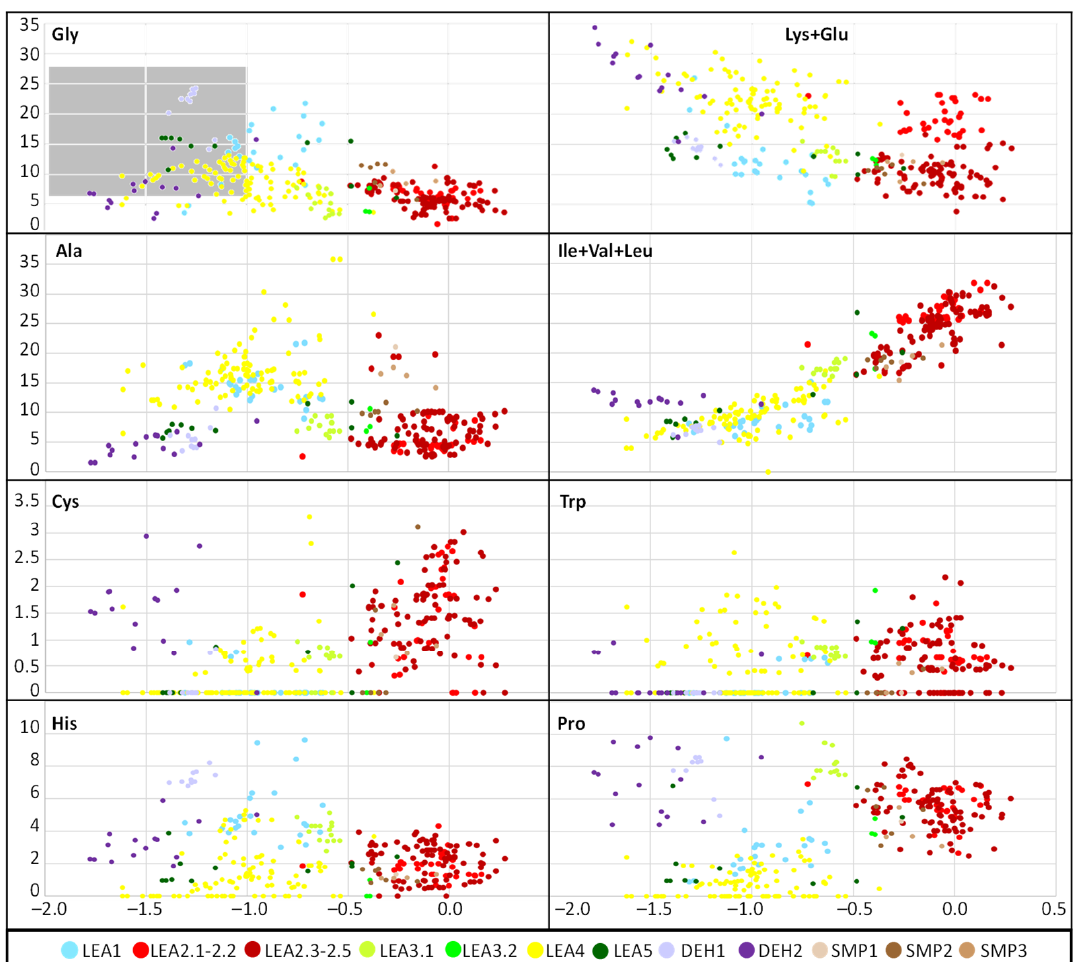
Figure 1. Percentage of selected amino acids and Gly versus GRAVY index plot in R. serbica LEA protein family members. The distribution of hydrophilins is highlighted in grey in the Gly/GRAVY plot.